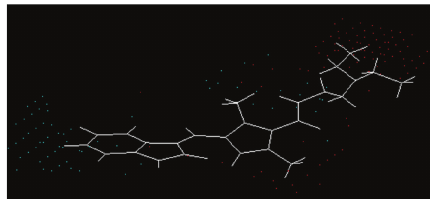
Figure 5: The shape master grid with compound 4. Red: steric bulk enhances the activity in this region. Blue: steric bulk detracts from activity in this region.